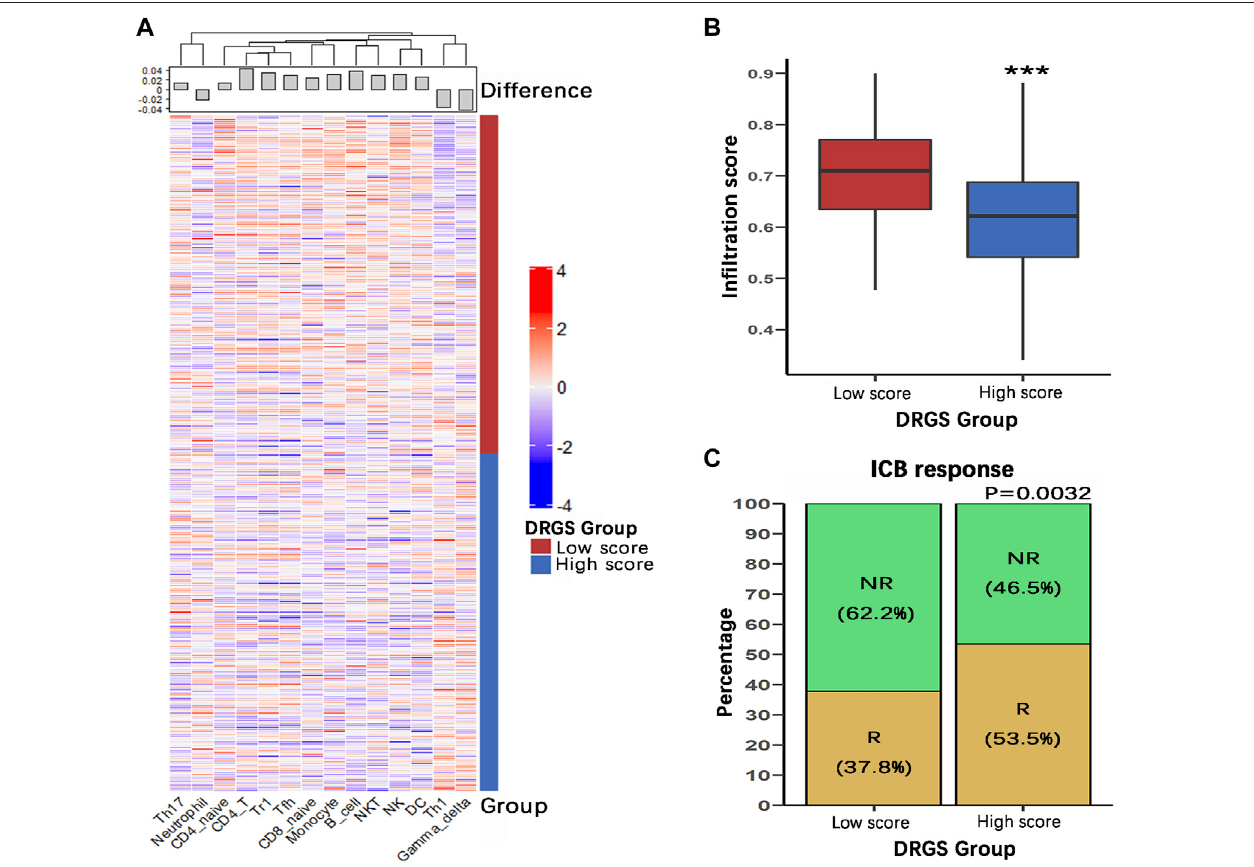
FIGURE 3| Immune characteristics of the DRGS score subgroups(High score n = 187, Low score n = 188). (A) Hierarchical clustering of various types of immune cells with signi fi cant differences in in fi ltration scores between the two score groups; (B) The overall in fi ltration score of low score group was signi fi cantly higher than the high score group; (C) ImmuCellAI was used to predict the response of ICB therapy. R: response; NR: no response. (* p < 0.05, ** p < 0.01, *** p < 0.001).